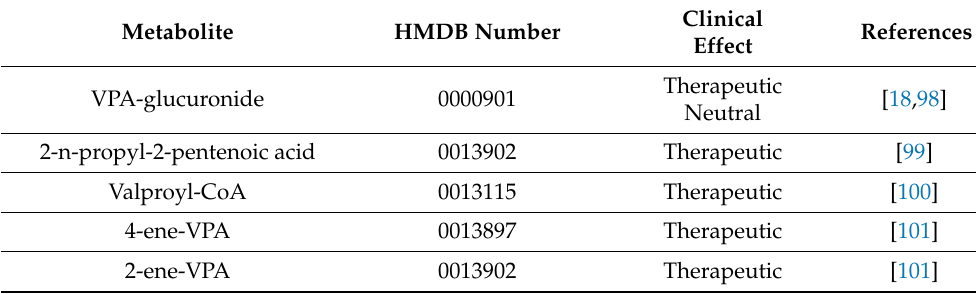
Table 1. Serum and Plasma Therapeutic Metabolites of Valproic Acid.